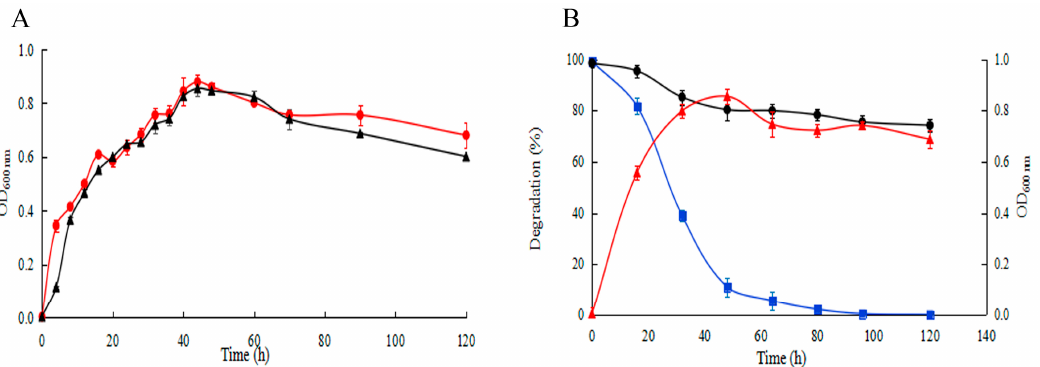
Figure 2. The growth of Bacillus cereus BCC01 and degradation of beta-cypermethrin. ( A) The growth curves of strain BCC01. ● , LB media; ▲ , with 100 mg/L Beta-cypermethrin in LB media. ( B) Bacterial growth and related degradation of beta-cypermethrin. ● , beta-cypermethrin control without bacteria; ▲ , growth in 100 mg/L beta-cypermethrin; and ■ , degradation of beta-cypermethrin with Bacillus cereus BCC01.